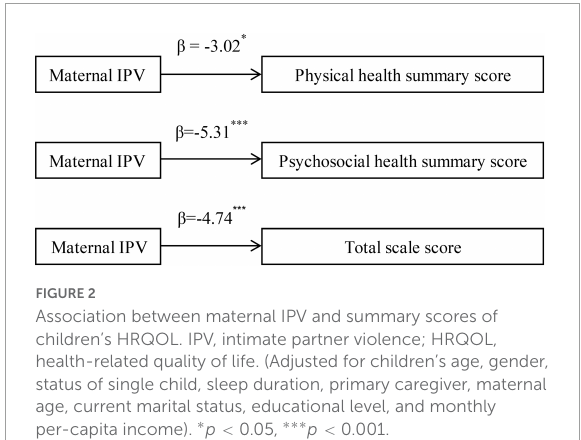
FIGURE2 Association between maternal IPV and summary scores of children’s HRQOL. IPV, intimate partner violence; HRQOL, health-related quality of life. (Adjusted for children’s age, gender, status of single child, sleep duration, primary caregiver, maternal age, current marital status, educational level, and monthly per-capita income). ∗ p < 0.05, ∗∗∗ p <